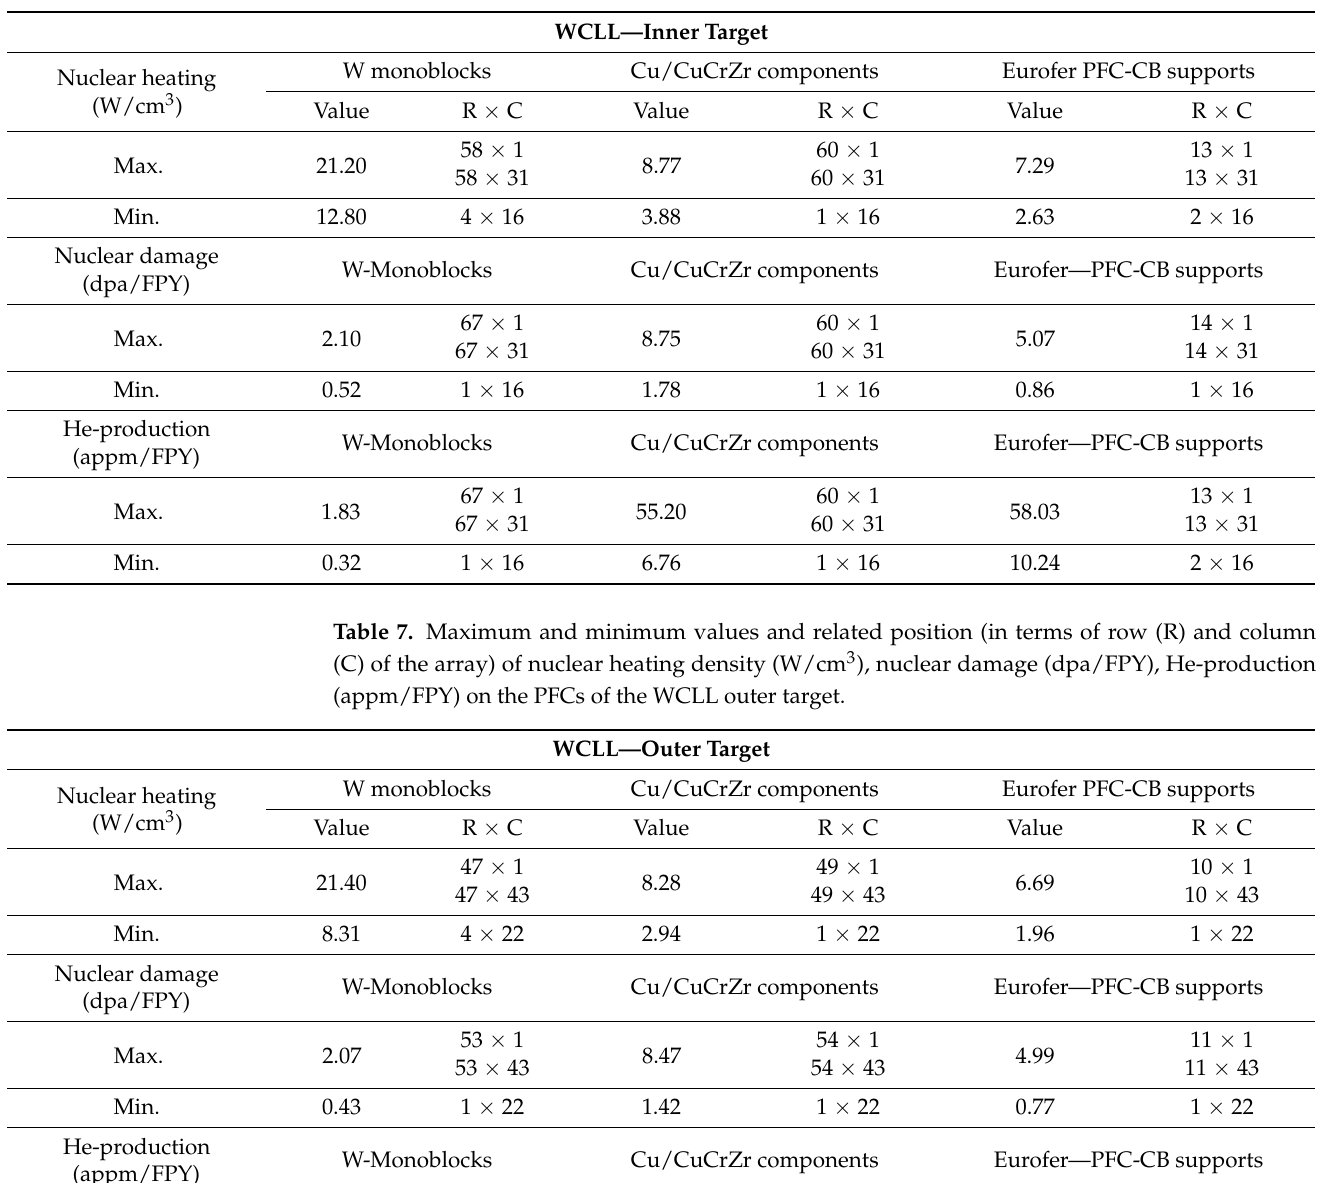
Table 6. Maximum and minimum values and related position (in terms of row (R) and column (C) of the array) of nuclear heating density (W/cm 3 ), nuclear damage (dpa/FPY), He-production (appm/FPY) on the PFCs of the WCLL inner target.